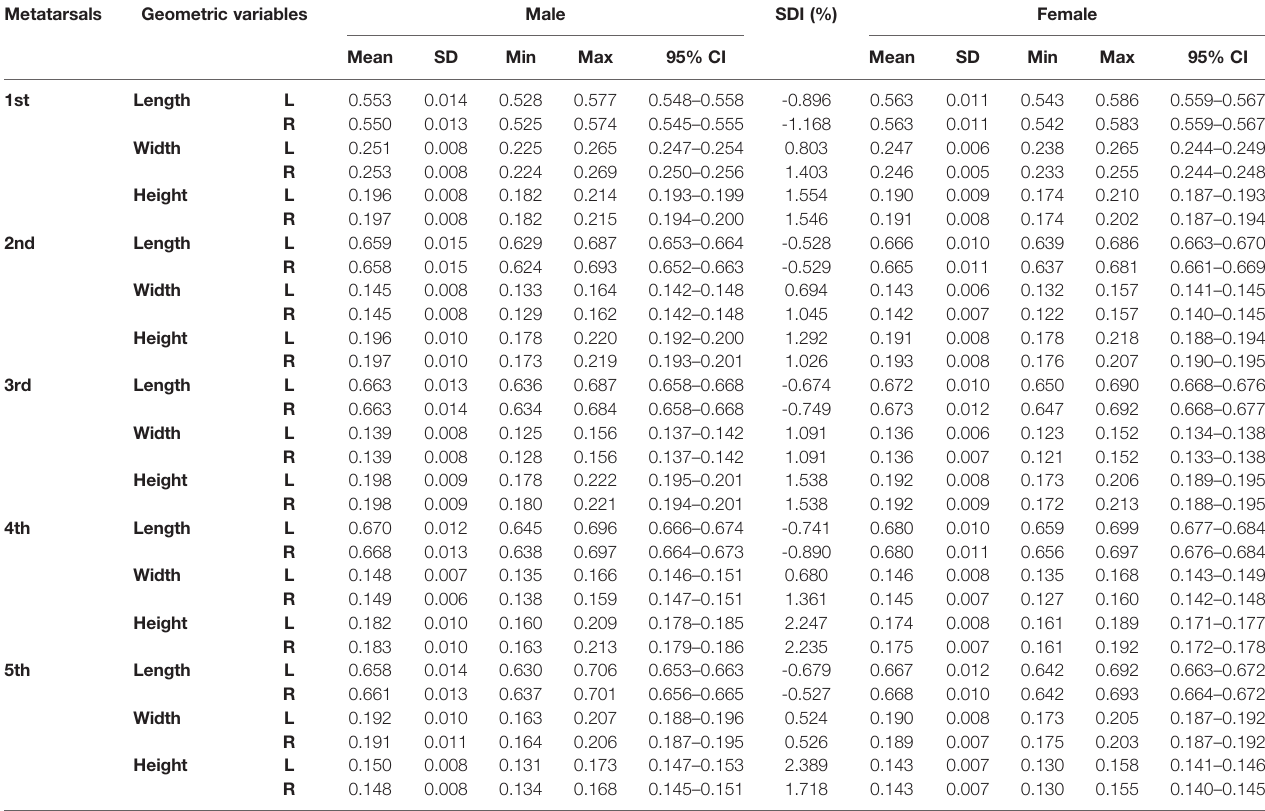
TABLE 1 | Descriptive results of normalized length, width, and height of metatarsal bone in vivo based on its PAI. Metatarsals Geometric variables